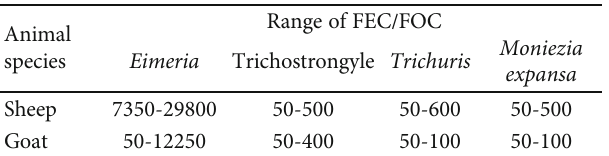
Table 4: Measurement of GIT parasite eggs and oocyst of sheep and goats. Parasite